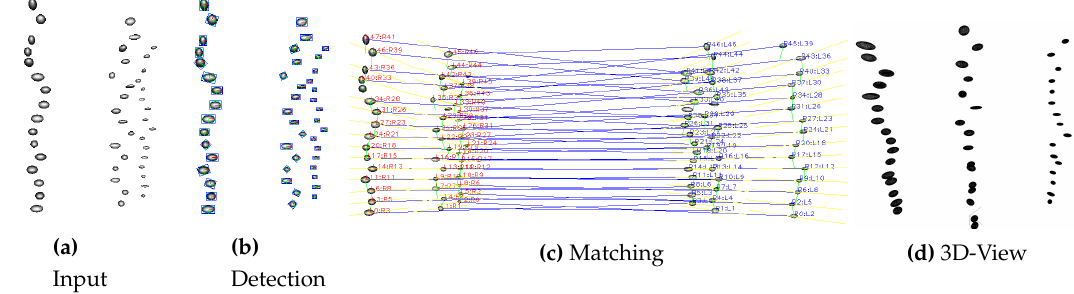
Figure 14. Exemplary simulator images. From left to right : input image, bubble detection result, matching result, and 3D view of the original 3D bubbles. In case of the matching image ( c ), the blue line indicates matching bubbles and the yellow lines indicate the local approximations of the epipolar